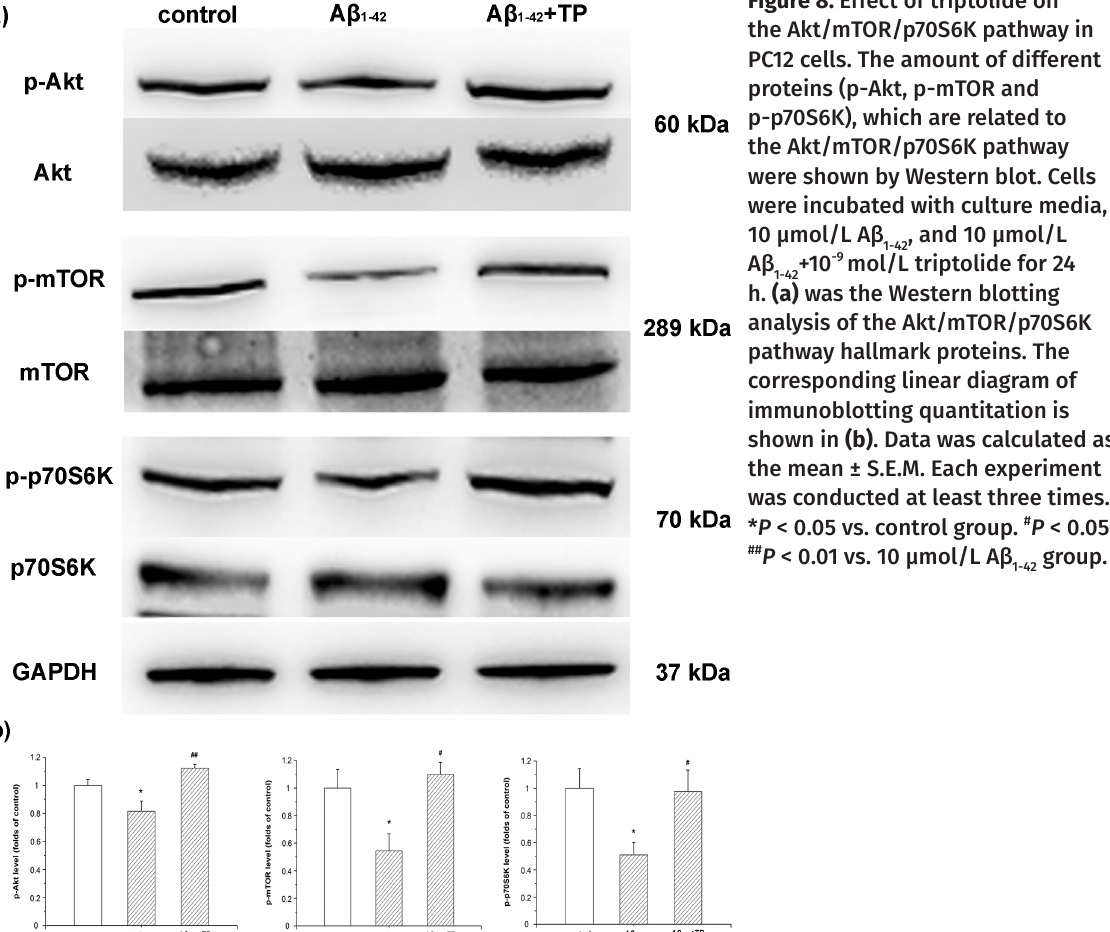
Figure 8. Effect of triptolide on the Akt/mTOR/p70S6K pathway in PC12 cells. The amount of different proteins (p-Akt, p-mTOR and p-p70S6K), which are related to the Akt/mTOR/p70S6K pathway were shown by Western blot. Cells were incubated with culture media, , and 10 μmol/L 10 μmol/L Aβ 1-42 +10 -9 mol/L triptolide for 24 Aβ 1-42 h. (a) was the Western blotting analysis of the Akt/mTOR/p70S6K pathway hallmark proteins. The corresponding linear diagram of immunoblotting quantitation is shown in (b) . Data was calculated as the mean ± S.E.M. Each experiment was conducted at least three times. * P < 0.05 vs. control group. # P < 0.05, ## P < 0.01 vs. 10 μmol/L Aβ 1-42